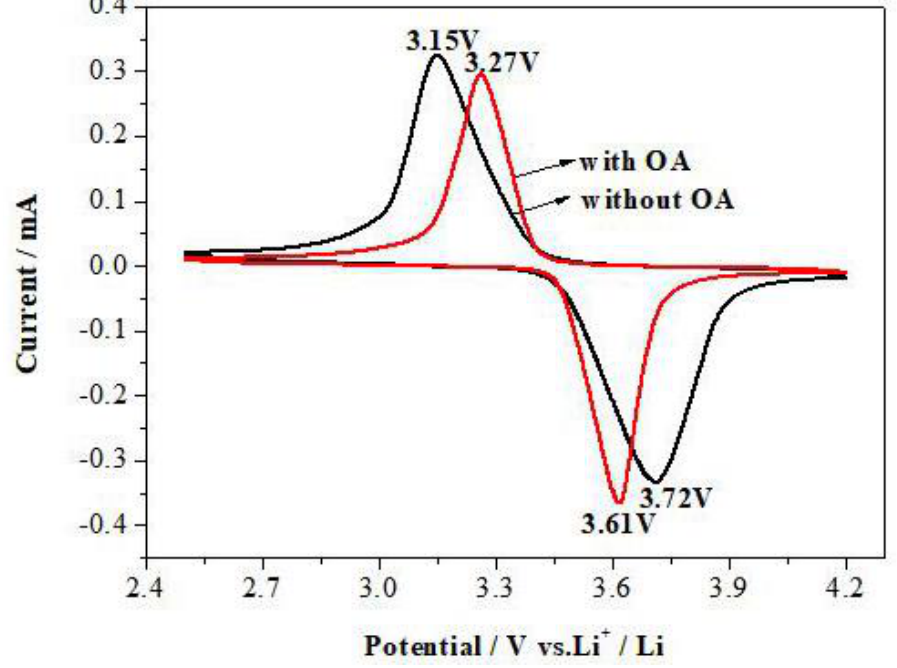
Figure 6. Cyclic voltametric profiles of LiFePO 4 electrodes prepared.